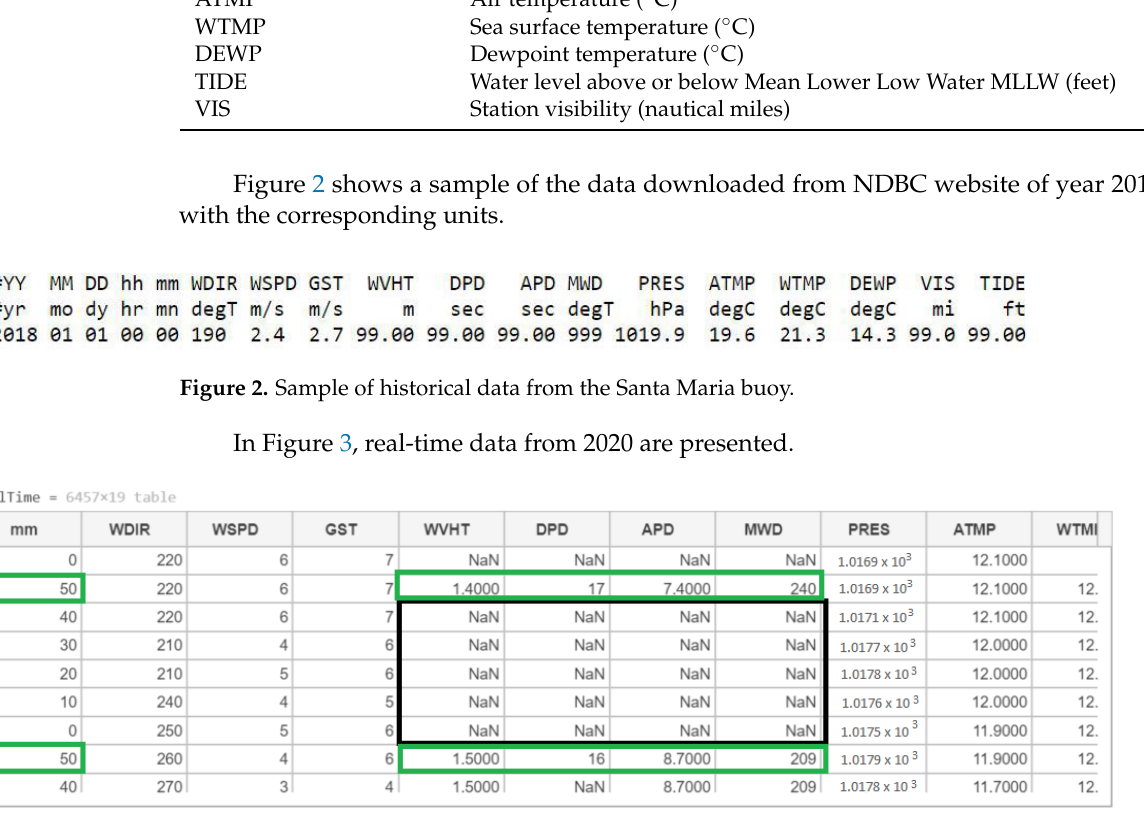
Figure 3. Sample of real-time values from the Santa Maria buoy.